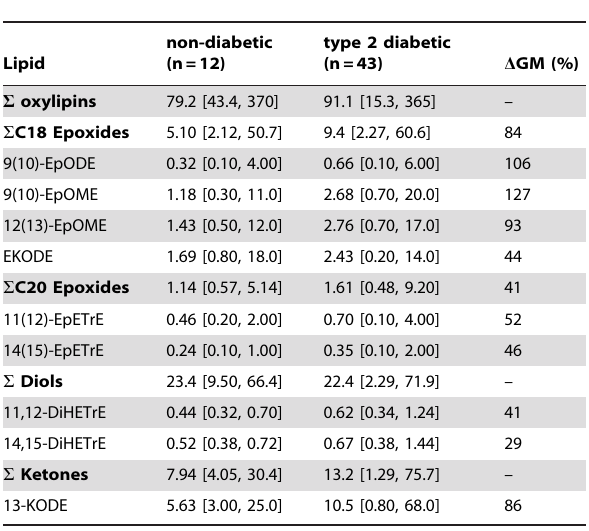
Table 5. Plasma N-acylamides and lipoamino acids (nM) in BMI-matched obese non-diabetic and type 2 diabetic African- American